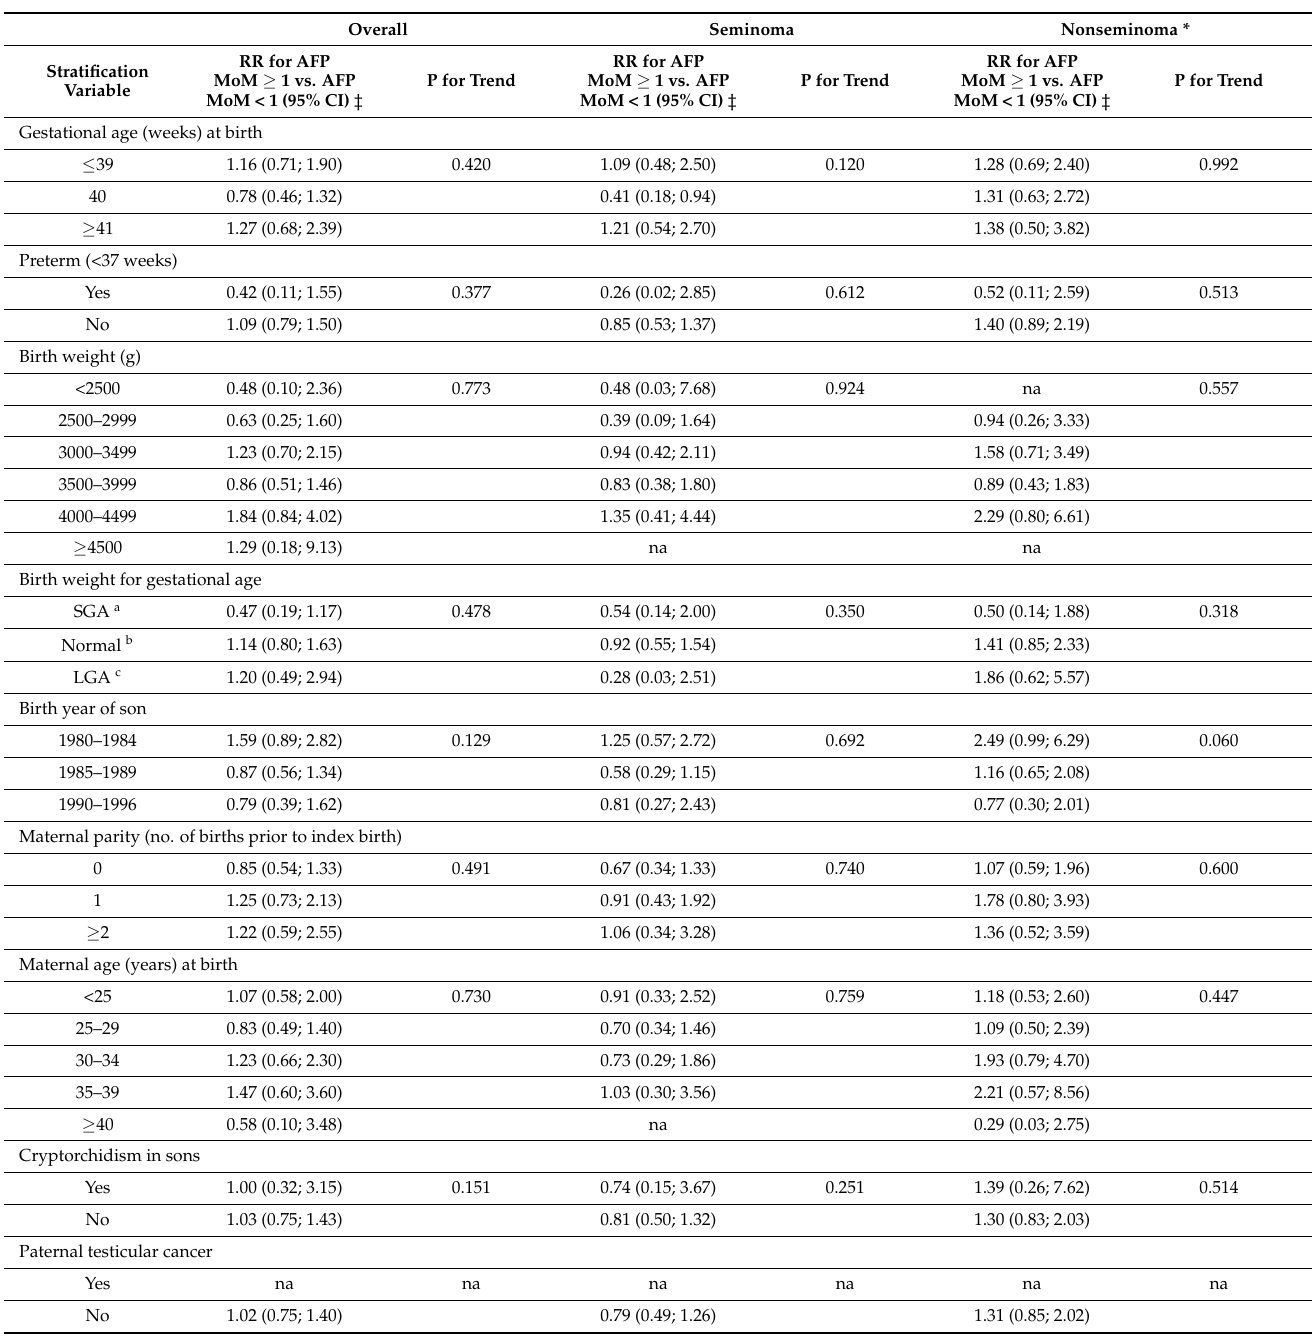
Table 3. Serum AFP ** and risk of testicular cancer (all) in offspring stratified by age, reproductive variables and other covariates in the cohort of 50,519 Danish singleton males and mothers stratified by AFP multiples of the median (MoM). Overall Seminoma Nonseminoma *